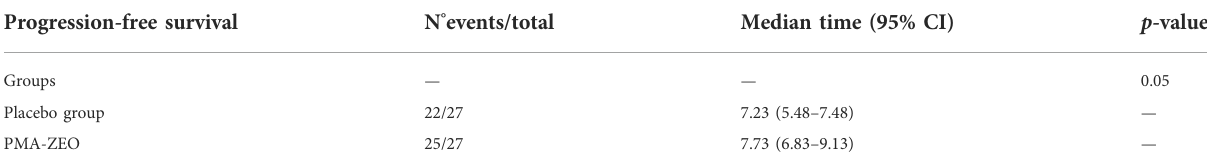
TABLE 3 PFS at the PMA-ZEO 7-month time point for cancer progression events in fi rst-line treatment patients.